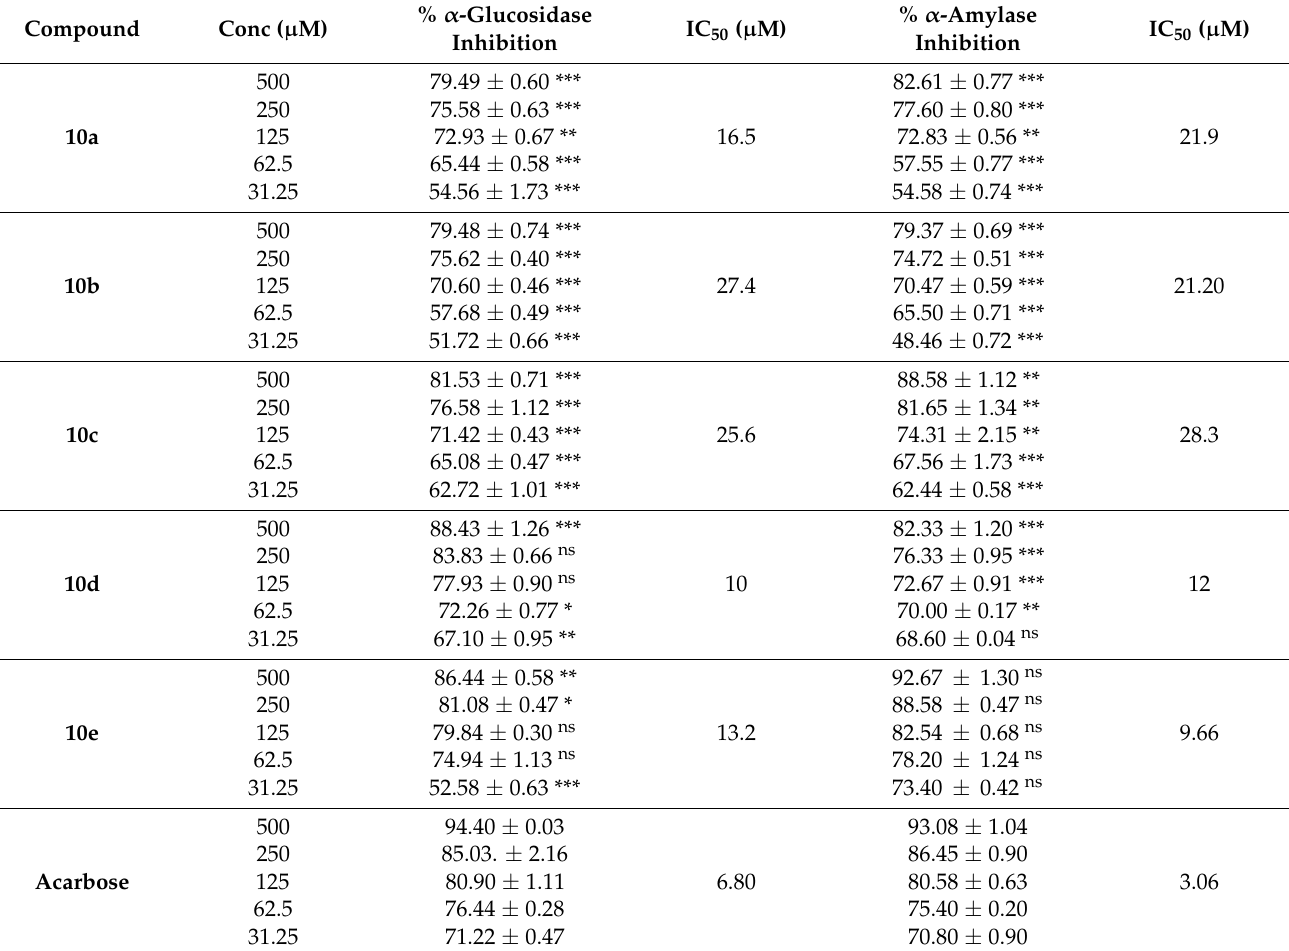
Table 1. In vitro α -glucosidase and α -amylase antidiabetic potential of test compounds 10a–e . Compound Conc ( µ M)